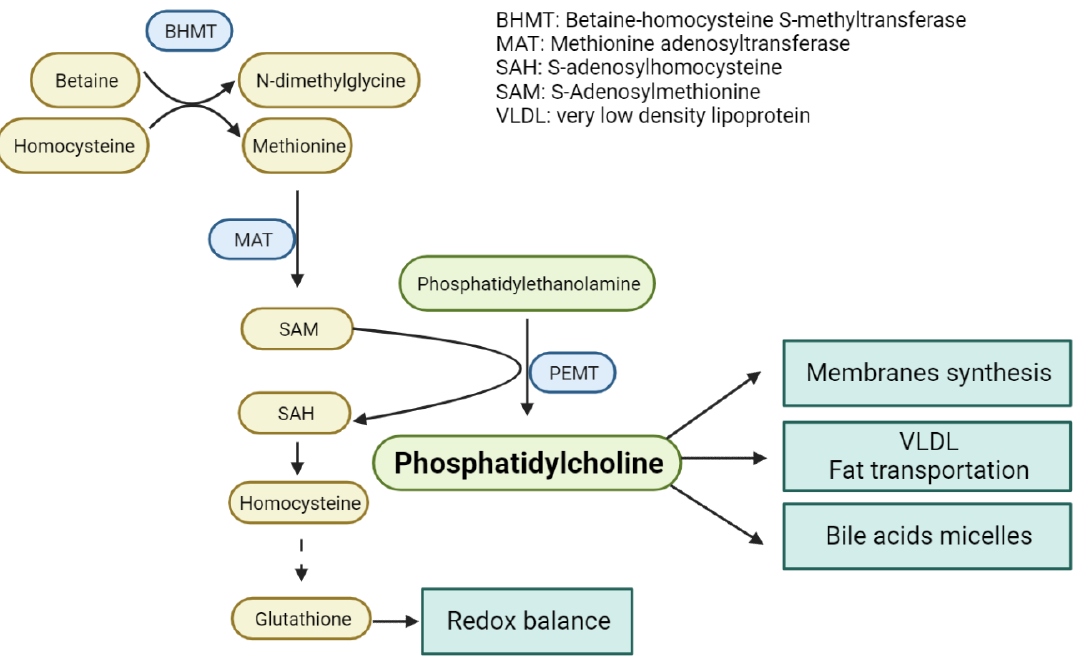
Figure 4. Phosphatidylcholine (PC) synthesis through one-carbon metabolism intermediates. SAM is an essential metabolite for PC synthesis as it is the methyl group donor in the three sequential methylation reactions of the precursor phosphatidylethanolamine (PE). This reaction is catalyzed by the PE N-methyltransferase.